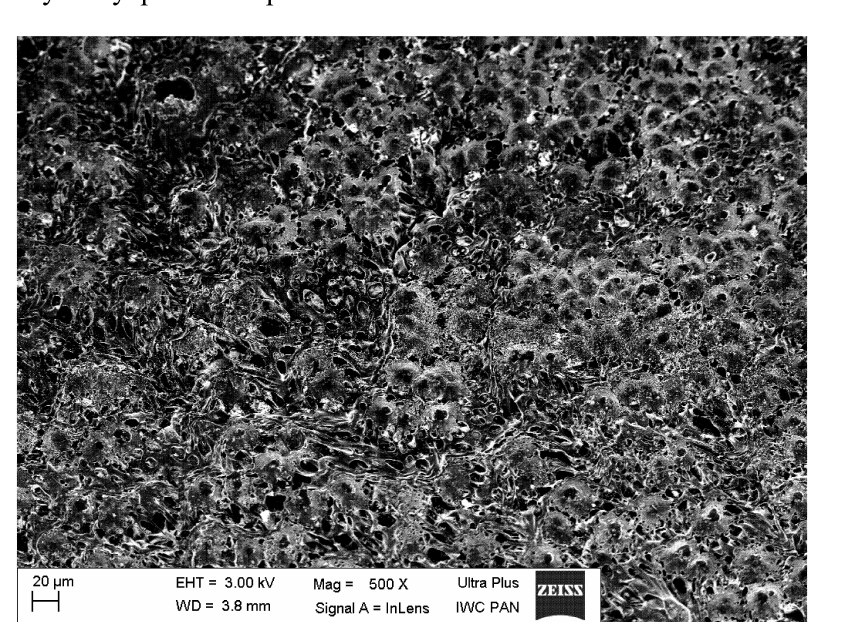
Figure 6. Scanning electron microscope (SEM) micrograph of the polyurethane/hydroxyapatite